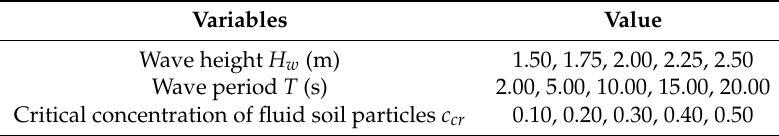
Table 2. Calculation cases of the parametric